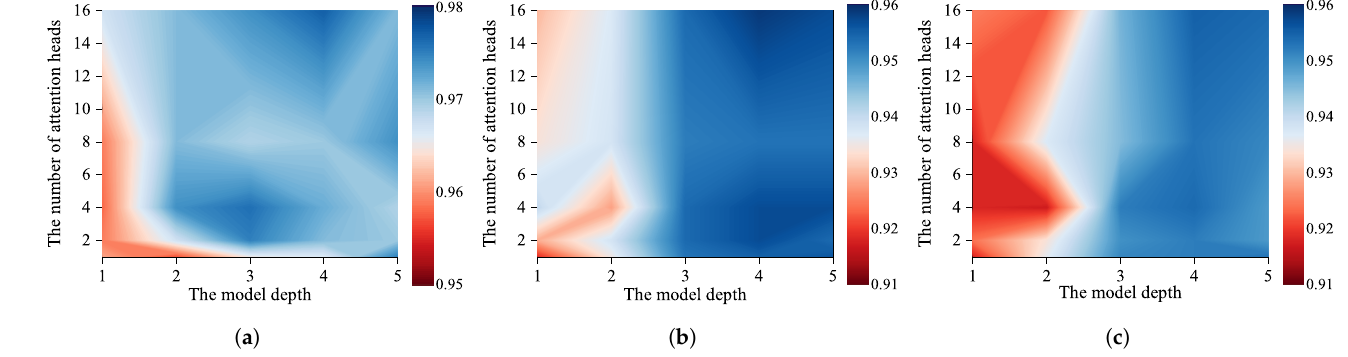
Figure 6. The heat maps show the effect of dynamically adjusting the encoder blocks and attention heads of the network on OA of three data sets. ( a ) PU data set, ( b ) SA data set, ( c ) IP data set.